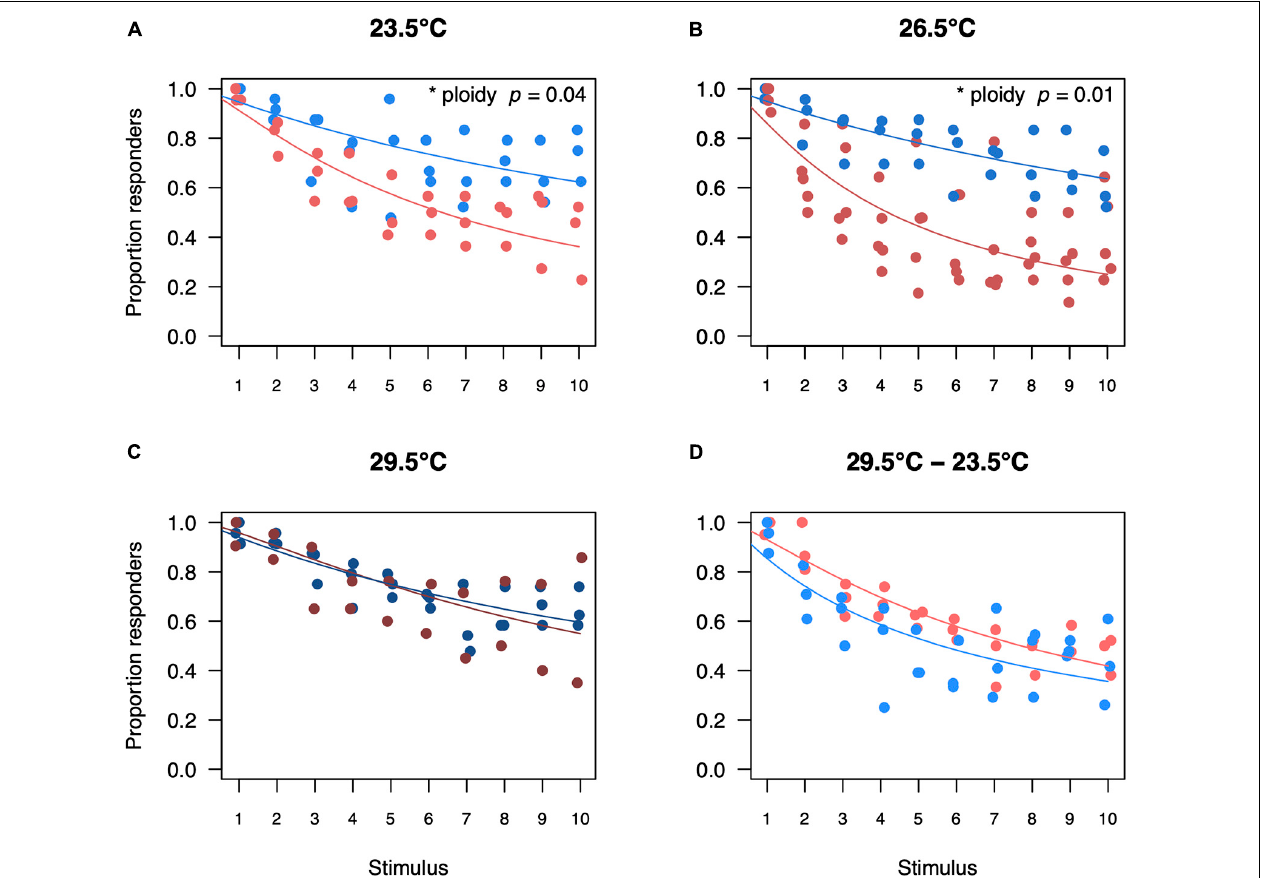
FIGURE 6 | Proportion of diploid and triploid responders for each startle stimulus per temperature treatment. Proportion of responders for diploid and triploid larvae reared and measured at 23.5 ◦ C (A) , 26.5 ◦ C (B) , 29.5 ◦ C (C) or reared at 29.5 ◦ C and measured at 23.5 ◦ C (D) . Depicted values are the proportion of responders per trial, where blue points represent diploid larvae and red points represent triploid larvae. Over all the effect of stimulus number was significant (ANOVA, p < 0.001, n = 250) as was the interaction between ploidy level and stimulus number (ANOVA, p < 0.05, n = 250). The effect of ploidy was also analyzed for a subset of each temperature treatment, comparing a model with and without ploidy level included. Ploidy was significant for larvae reared and measured at 23.5 ◦ C (ANOVA, p = 0.04, n = 60) and for larvae reared and measured at 26.5 ◦ C (ANOVA, p = 0.01, n = 80). Ploidy was not significant for larvae reared and measured at 29.5 ◦ C (ANOVA, p = 0.87, n = 50) and for larvae reared at 29.5 ◦ C and measured at 23.5 ◦ C (ANOVA, p = 0.06, n =